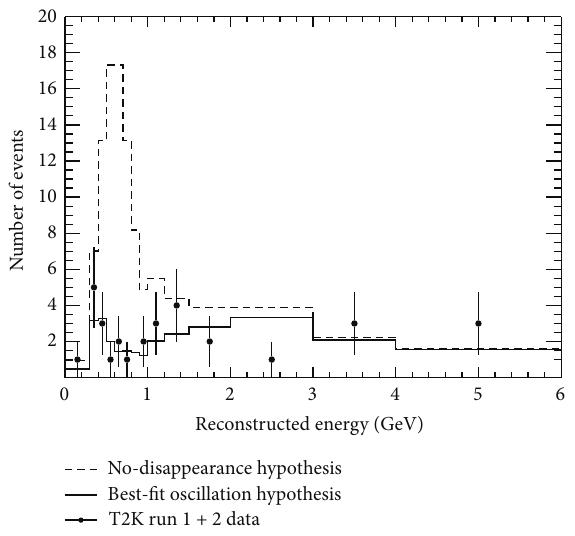
Figure 15: Reconstructed neutrino energy spectra of T2K 𝜈 𝜇 disappearance